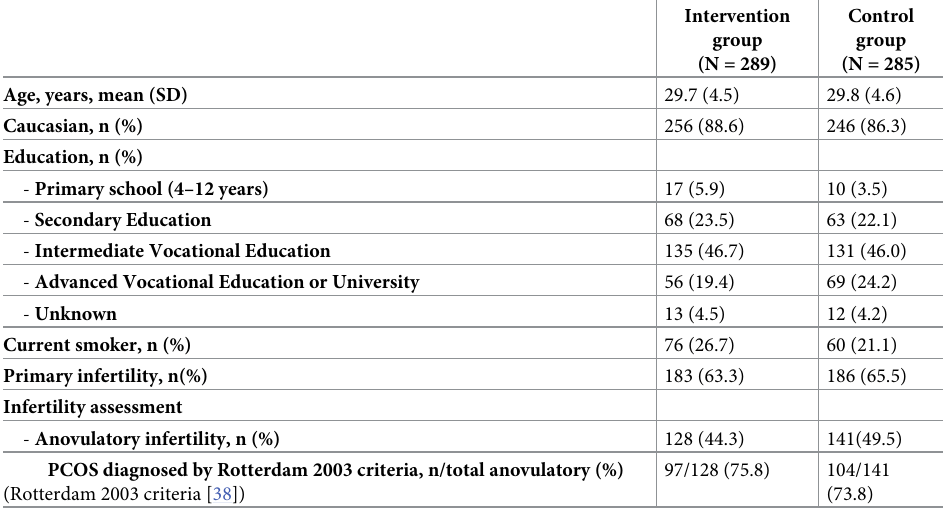
Table 1. Baseline characteristics of study participants in intervention and control